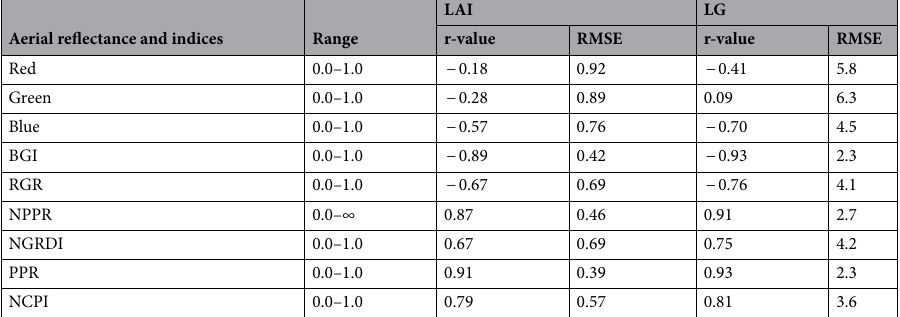
Table 5. Relationship between leaf area index (LAI) and lateral growth (LG) with leaf reflectance and vegetation indices. Pearson’s correlation coefficients (r-value) and root mean square error (RMSE) has been used to determine the relationship. The reflectance and vegetation indices has been derived on 18 peanut genotypes across growth stages in 2017.